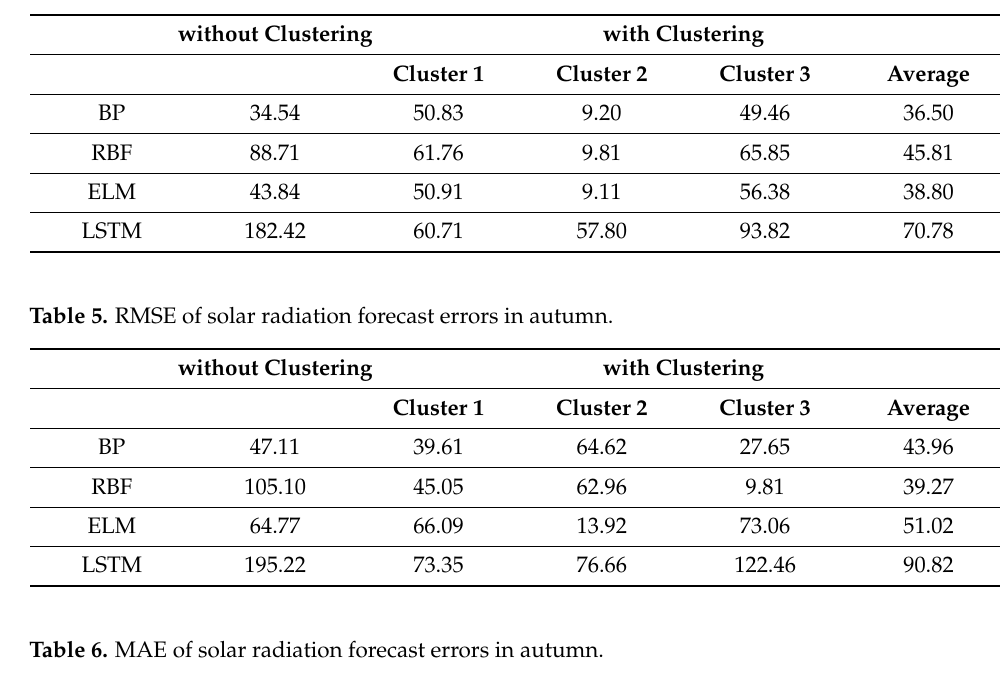
Table 4. MAE of solar radiation forecast errors in summer.